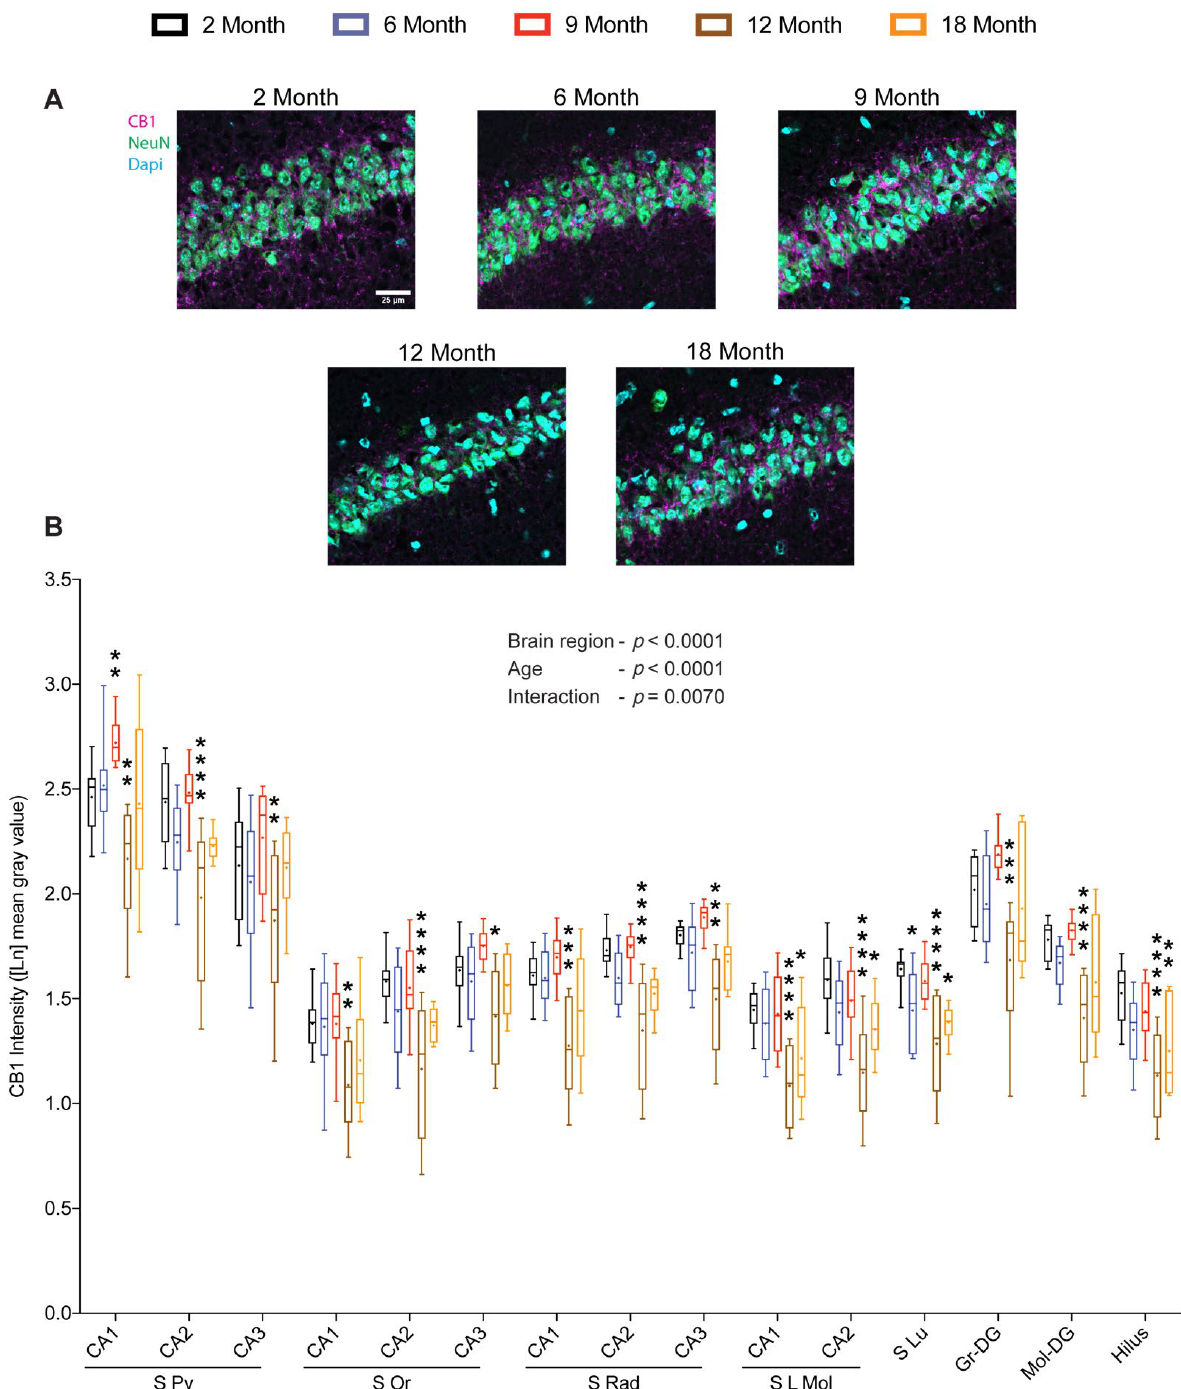
Figure 3. Effect of age on CB1 protein levels in the hippocampus. Coronal brain sections of 2-, 6-, 9-, 12- and 18-month-old mice were immunostained for CB1 receptor. Representative images depicting CB1 immunoreactivity in the CA1 region (scale bar = 25 μm) ( A ). Quantification of CB1 immunoreactivity across the sub-regions of the hippocampus revealed significant changes in CB1 protein levels with respect to age and brain region ( B ). ( n = 9–12 images were analyzed from 3–4 mice per age group). Whiskers represent minimum and maximum values; + symbol within the box indicates mean; * p < 0.05; ** p < 0.01; *** p < 0.001; **** p < 0.0001; linear mixed model analysis followed by Dunnett ´ s multiple comparison test. p -values refer to pairwise tests against the 2-month-old